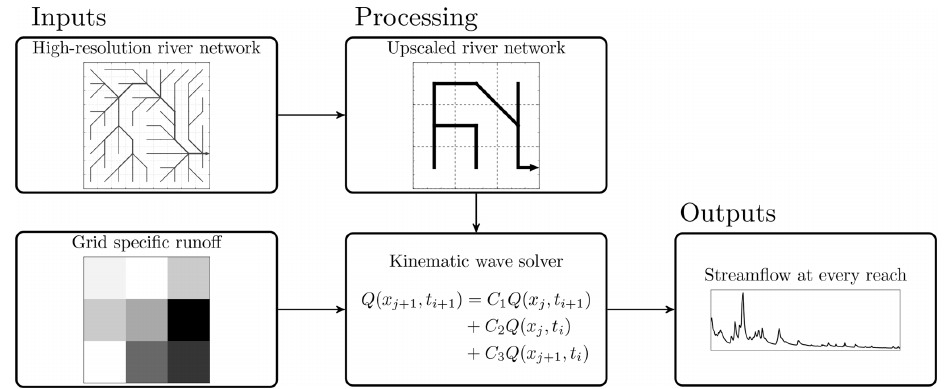
Figure 1. Flowchart of the processing steps required to run the multiscale routing model mRM. Left, inputs: static high-resolution information about the routing network and dynamic runoff field. Middle, internal mRM processing: aggregation of static and dynamic data to the routing resolution given by the user and execution of routing at this resolution. Right, output: calculated streamflow at prescribed